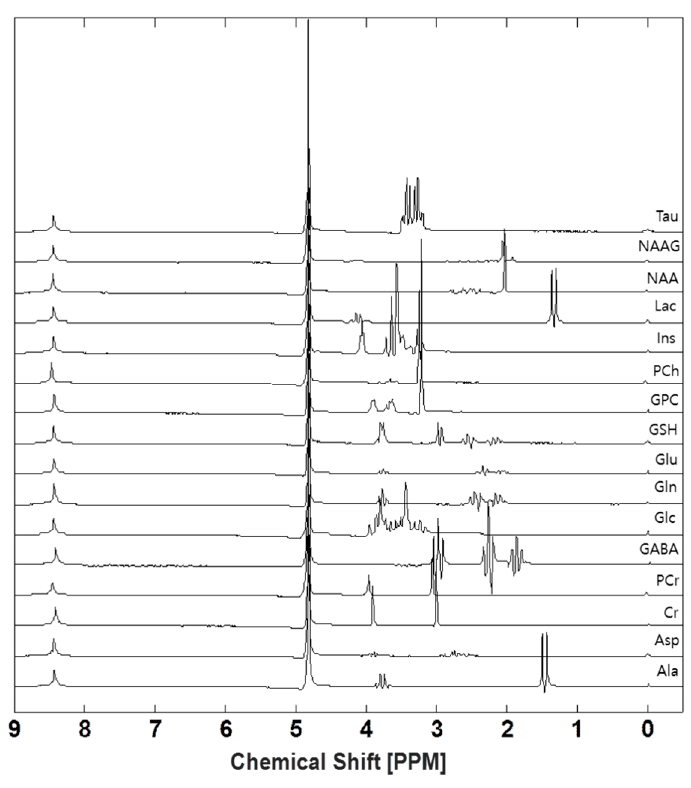
Figure 1. In-house experimentally acquired basis set generated using a phantom.